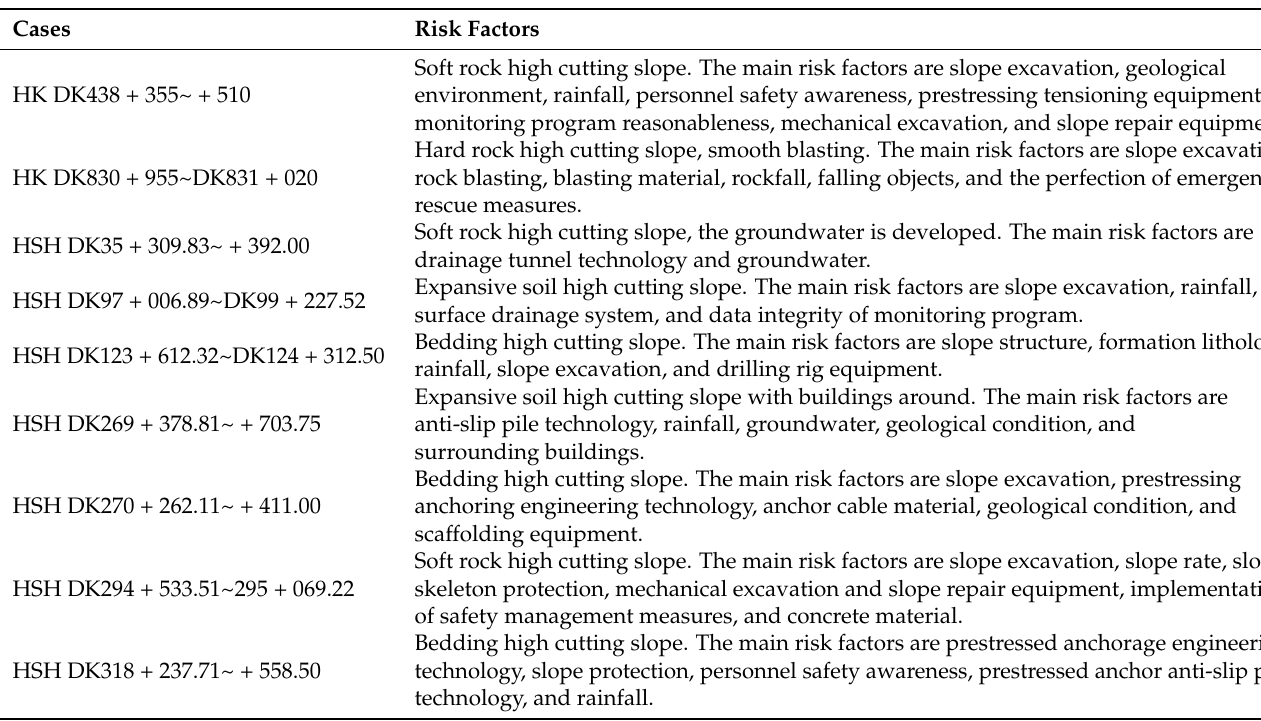
Table 3. Construction safety risk identification based on statistical analysis of